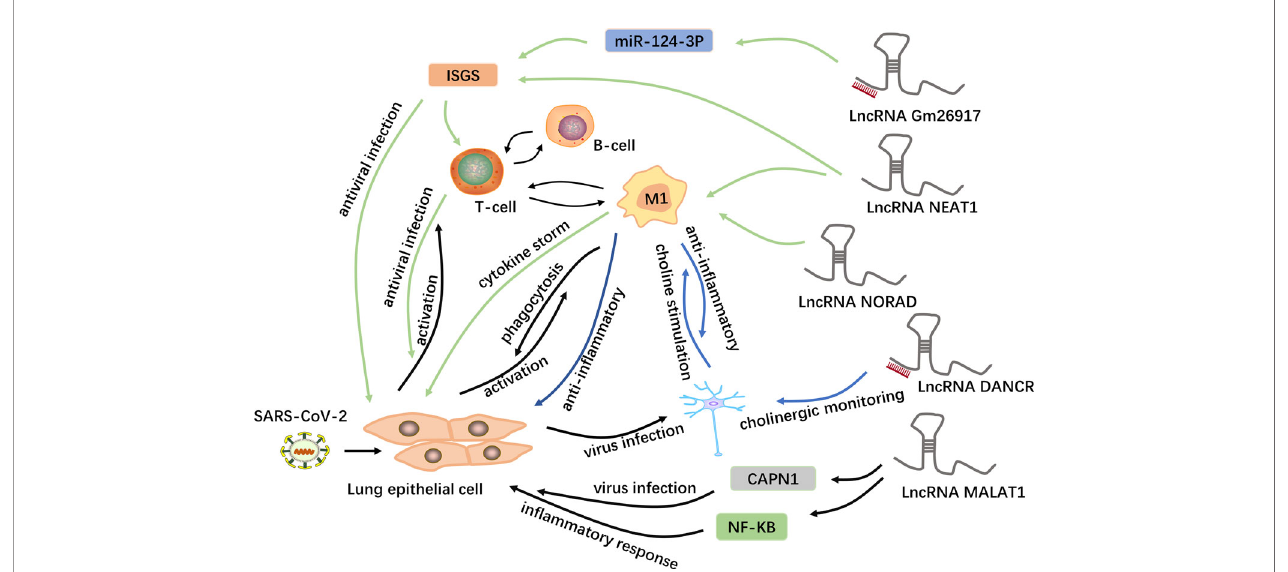
FIGURE 3 | Potential mechanisms of lncRNAs in COVID-19. LncRNAs are a new class of regulatory factors that mediate host-virus interactions. The lncRNA GM26917 acts as an “ miRNA sponge ” and interacts with miR-124-3p to regulate the expression of IFN-stimulating genes (ISGs) (48). On the one hand, the epithelial cells themselves produce type 1 interferons to resist viral infection; on the other hand, the activated immune cells release interferons in large quantities to control the viral replication in the cell. In addition to regulating the expression of ISGs, the lncRNA NEAT1 is also associated with the NLRP3, NLRC4 and AIM2 in fl ammasomes in macrophages, thus participating in the induction of in fl ammation (93). The lncRNA NORAD can target fi ve of the ten cytokines involved in cytokine storms and is thus involved in cytokine storms (44). In addition, the lncRNA MALAT1 is highly likely to regulate lung in fl ammatory injury caused by cytokines through the NF-kB, and can also target and down-regulate CAPN1, participating in viral infection (8, 93 – 95). Moreover, some viruses can spread from the lungs to the central nervous system via a blood-borne route. The lncRNA DANCR is potentially the chief regulator responsible for the surveillance of in fl ammatory cholinergic blockades and thus plays distinct roles in pneumonia and neuroin fl ammation (46). Acetylcholine interacts with macrophages to inhibit the synthesis of in fl ammatory